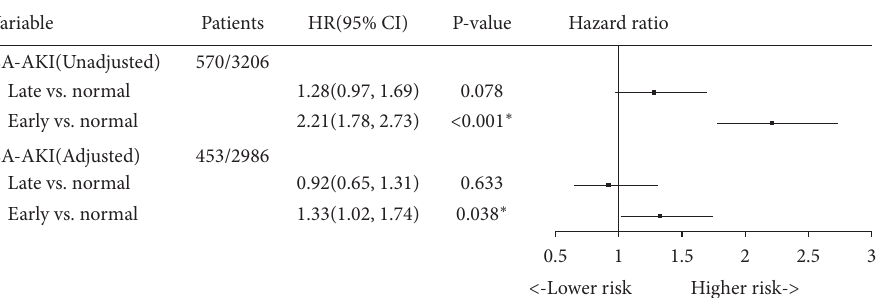
Figure 3: Multivariable analysis for mortality stratified according to early, late, and normal. Adjusted for age ≥ 75, male, acute myocardial infarction, chronic heart failure, hypertension, anemia, contrast media volume, beta-blocker uses, statin use, and diuretic uses; CA-AKI defined as an increase ≥ 50% or ≥ 0.3mg/dL from baseline.